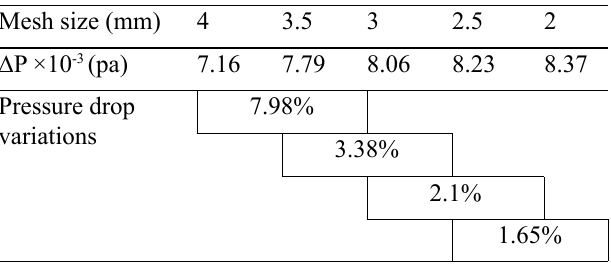
Table 6. Grid independence results for packed bed with truncated cone particles in N=6.54.